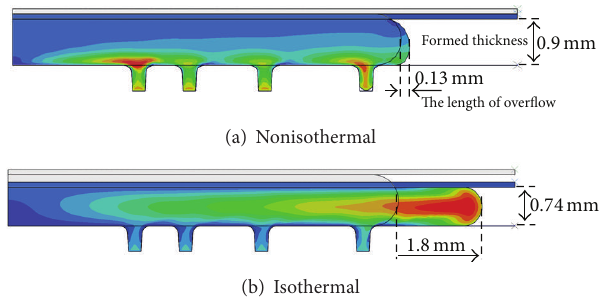
Figure 12: Comparison of nonisothermal and isothermal hot embo-